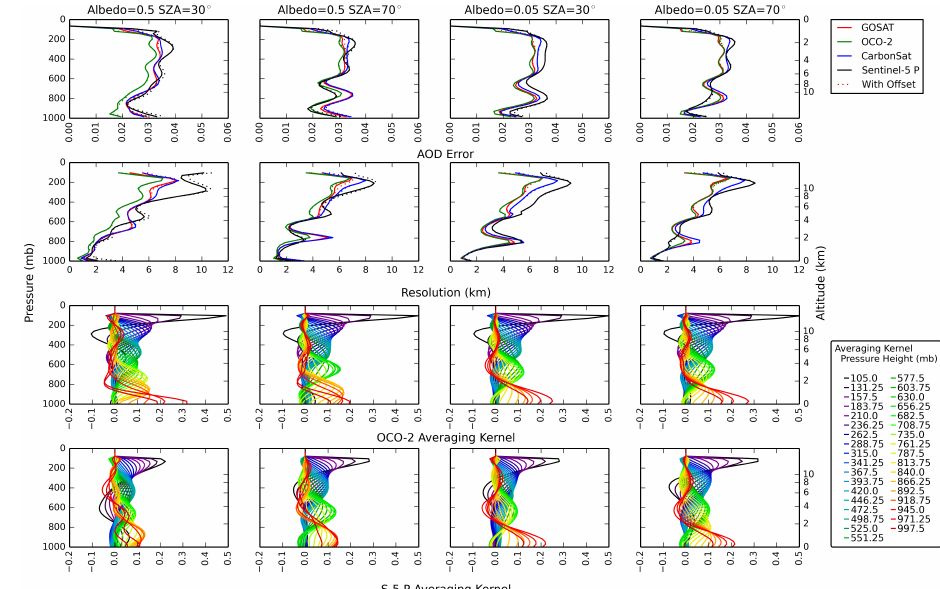
Figure 5. As Fig. 4 but for scenario